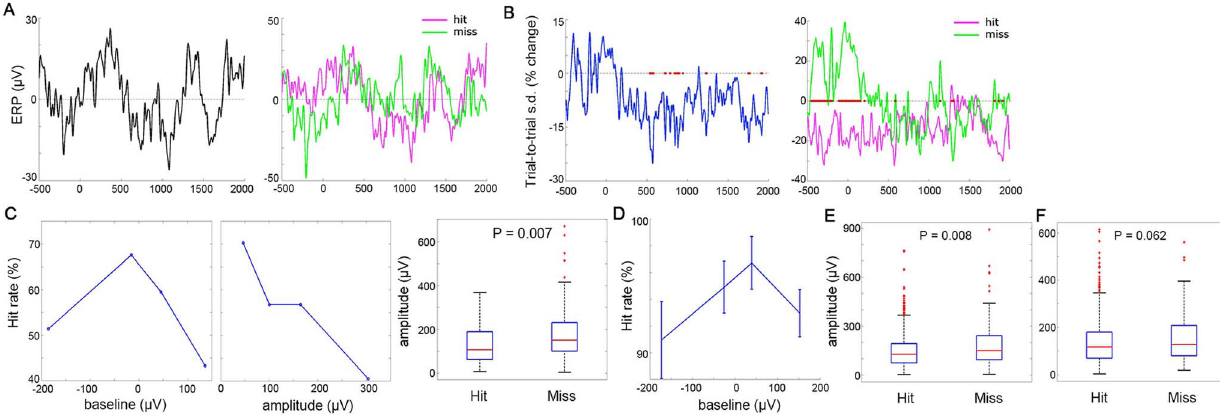
Figure 3. Inverted-U relationship between ECoG activity (the first PC) and hit rate. ( A–C ) Results from the first PC in Pt # 1 (contralateral data). ( A ) Left: Averaged ERP across all trials. Right: Averaged ERP for hit and miss trials separately. ( B ) Left: Across-trial variability time course; red dots: P , 0.005 (F-test, compared against pre-stimulus period). Right: Across-trial variability time course (normalized to the pre-stimulus mean computed across all trials) for hit (N=83) and miss (N=66) trials separately; red dots: P , 0.005 (F-test, hit vs. miss trials). ( C ) Left: Hit rate as a function of raw ECoG activity at stimulus onset. Middle: Hit rate as a function of rectified ECoG signal amplitude at stimulus onset. Right: ECoG signal amplitude at stimulus onset for hit vs. miss trials (P=0.007, Wilcoxon rank-sum test). Red line and the edges of the box denote median, 25 th and 75 th percentiles respectively. The whiskers extend to the range for data not considered outliers and the crosses indicate the outliers. ( D ) Hit rate as a function of ECoG activity (from the first PC) at stimulus onset, averaged across Patients # 2–5 (contralateral data). ( E ) ECoG signal amplitude (from the first PC in each subject, contralateral data) at stimulus onset for hit vs. miss trials (P=0.008, Wilcoxon rank-sum test). Data were pooled across all five subjects. ( F ) Same as E , except using ipsilateral data across 5 subjects. Hit vs. miss: P=0.062 (Wilcoxon rank-sum test).